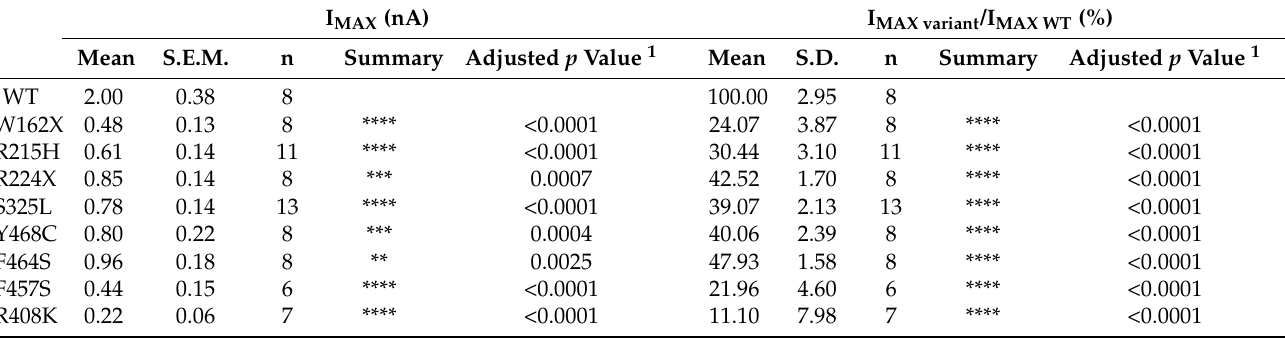
Table 3. Effects of GABRG2 variants on α 1 β 3 γ 2 receptor macroscopic GABA-evoked